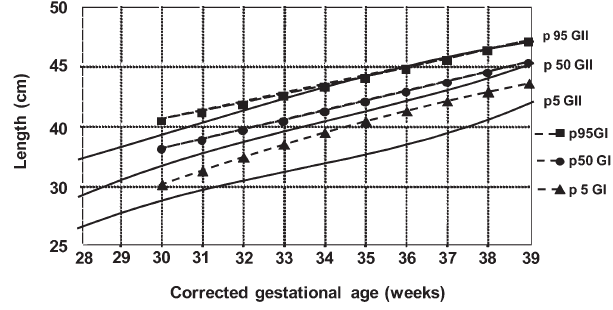
Figure 2 - Estimated values of 5 th , 50 th and 95 th percentiles of GI and GII VLBWI length